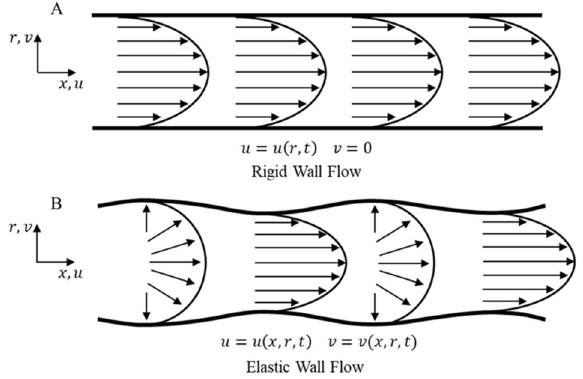
Figure 2. Fluid flow in rigid and elastic tubing (adapted 19 ). ( A ) The top diagram shows fully developed velocity profile for flow in a rigid walled tube. ( B ) Second diagram shows flow in an elastic walled tube.